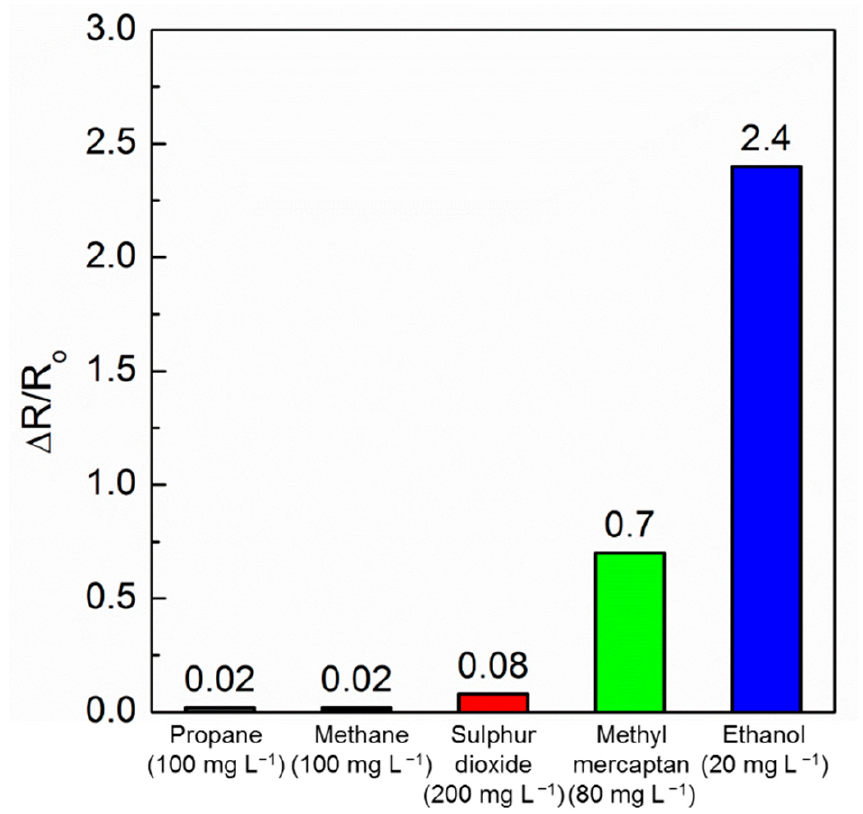
Figure 8. The responses of α -Fe 2 O 3 /Ag 3.0 wt% ethanol sensor at 25 °C towards possible interfer- ant gases.